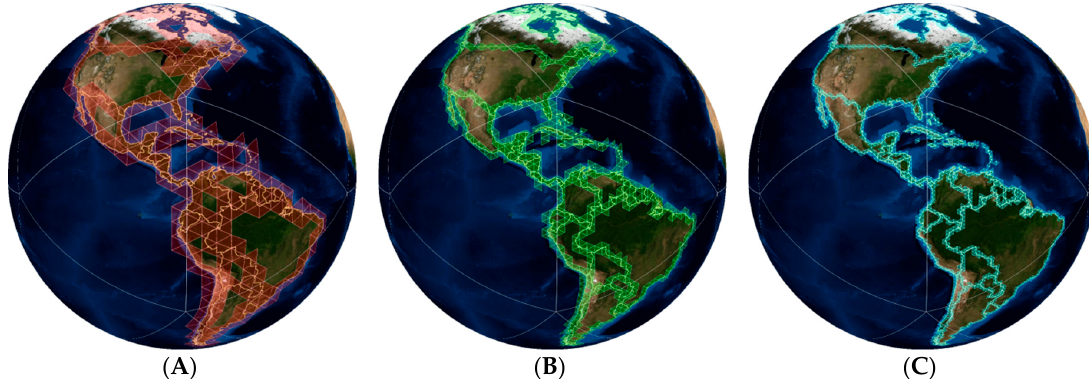
Figure 12. Multiresolution discretization of spherical vector data. The white arcs are the boundaries of the spherical triangles, and the figures represent the following: ( A ) the side length of grid cell is approximately 483 km; ( B ) the side length of grid cell is approximately 242 km; ( C ) the side length of grid cell is approximately 121 km.